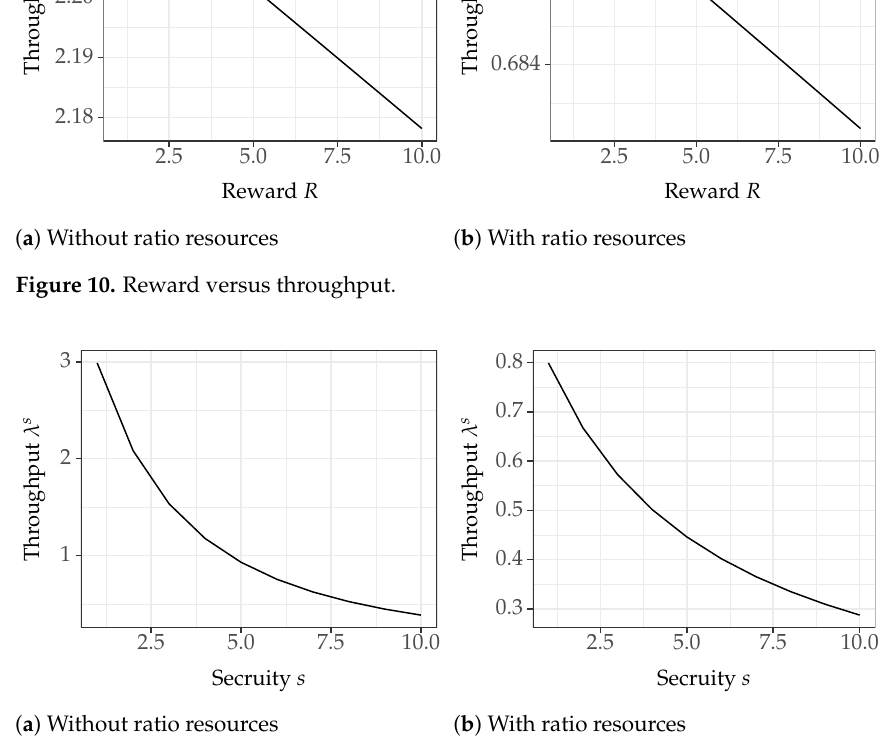
Figure 11. Security versus